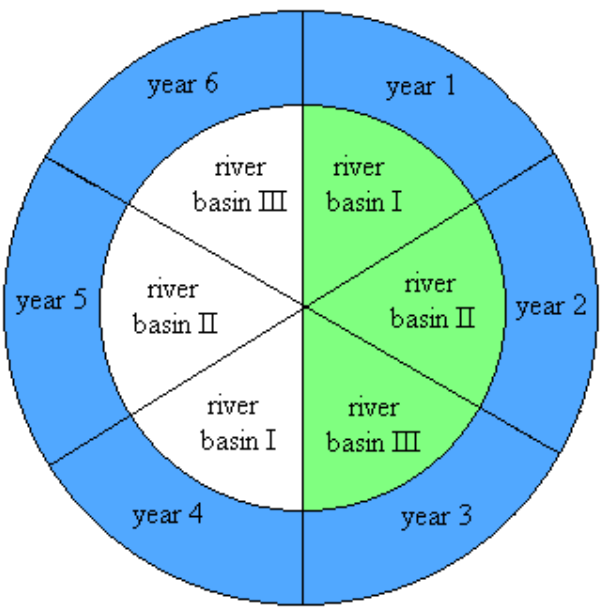
FIGURE 8. Monitoring scheme with three river basins. (Green shaded area = river basin management plan